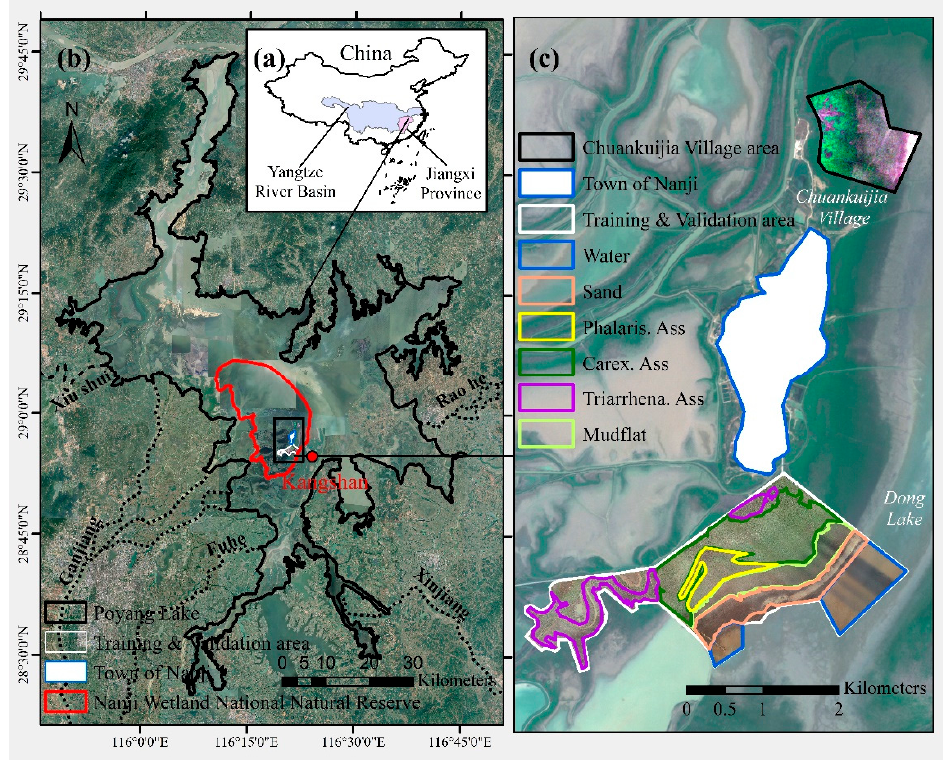
Figure 1. Map of the study area: ( a ) locations of the Poyang Lake in the Yangtze River Basin, China; ( b ) Nanji Wetland National Nature Reserve and Kangshan Station in Poyang Lake; ( c ) drone image of the area used for training and validation with different land covers.